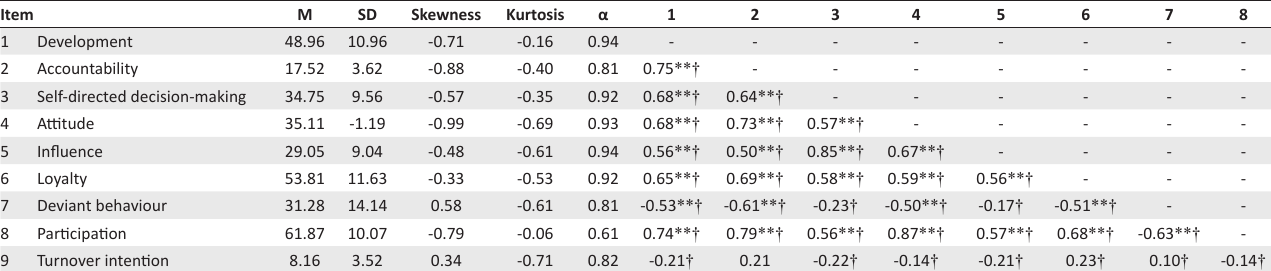
TABLE 2: Descriptive statistics, Cronbach’s alpha coefficients, and correlation coefficients of the measuring instruments. Item M SD 1